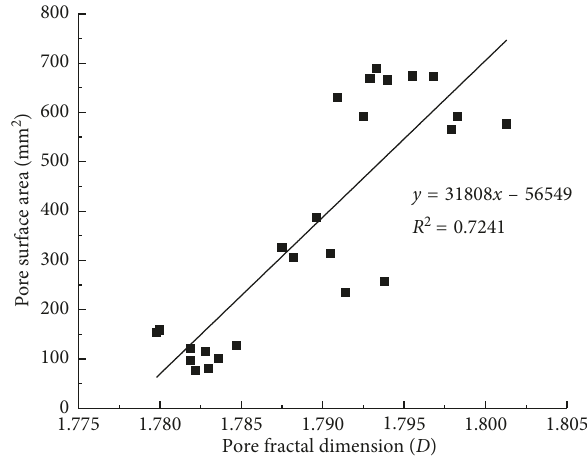
Figure 10: Relationship between pore fractal dimension and pore surface area.